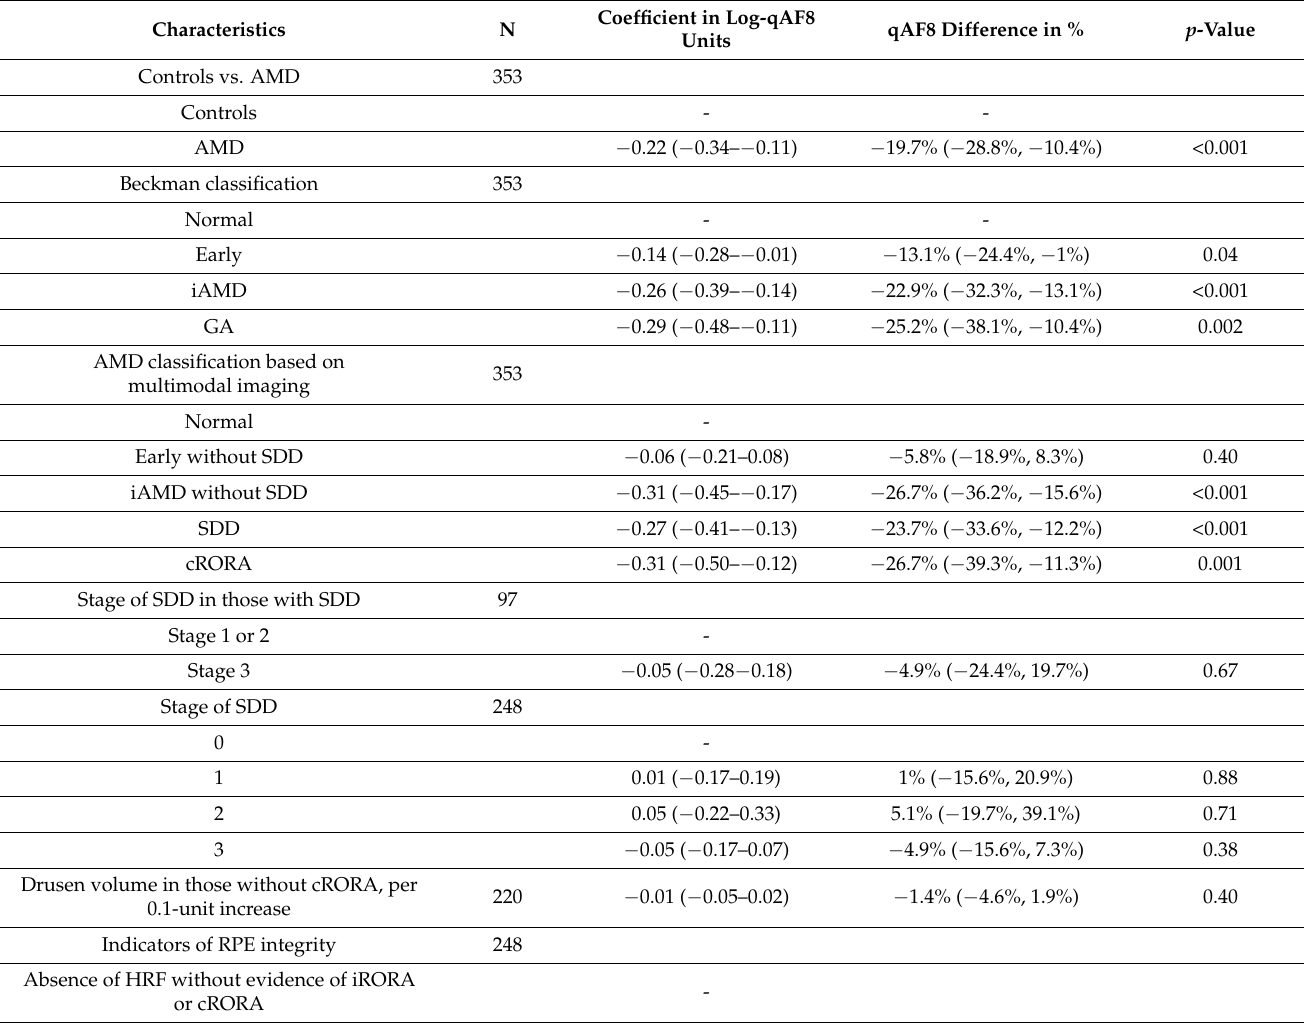
Table 2. Parameters associated with log-qAF8 mean adjusted for age, gender and lens status using GEE